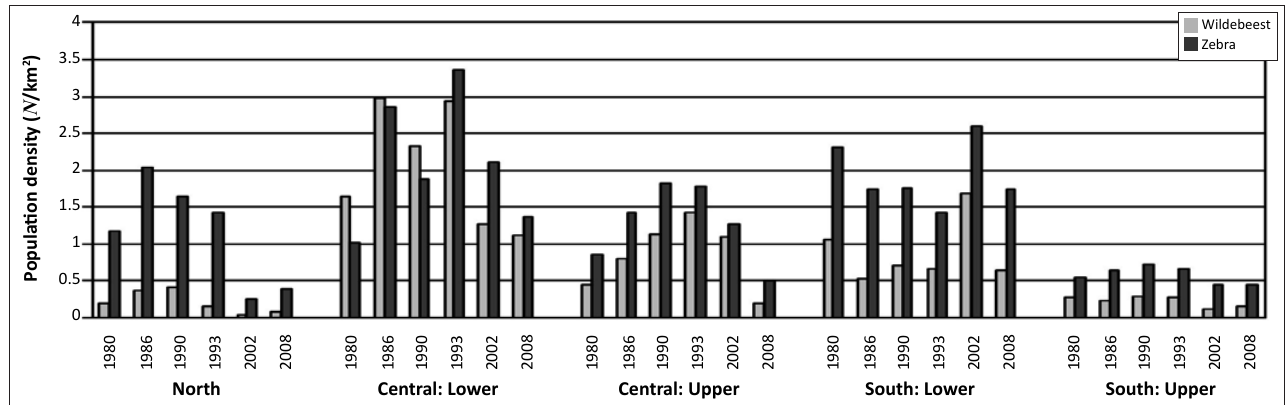
– T = diurnal temperature range) at (a) max min